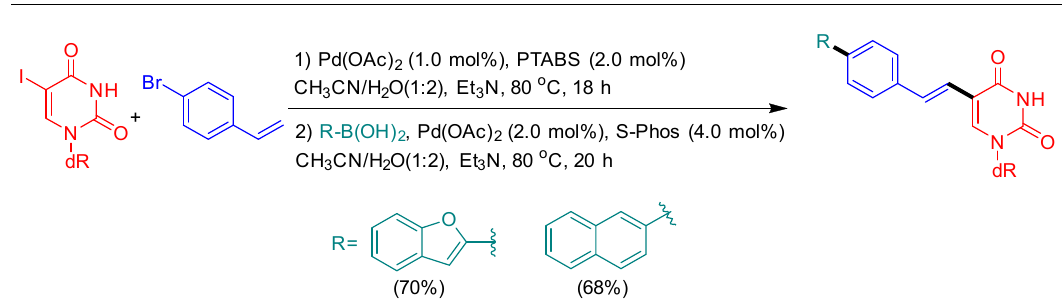
Figure 5. Summaryof the FV-100 synthesis protocols.